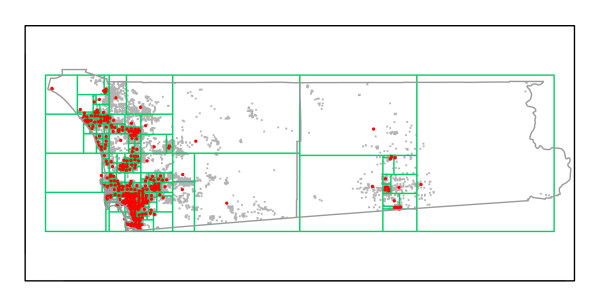
Set 1 Epiunit areal units with maximum 1,000 births, for RC A. Population centroids for each unit are red. All located births are gray points.